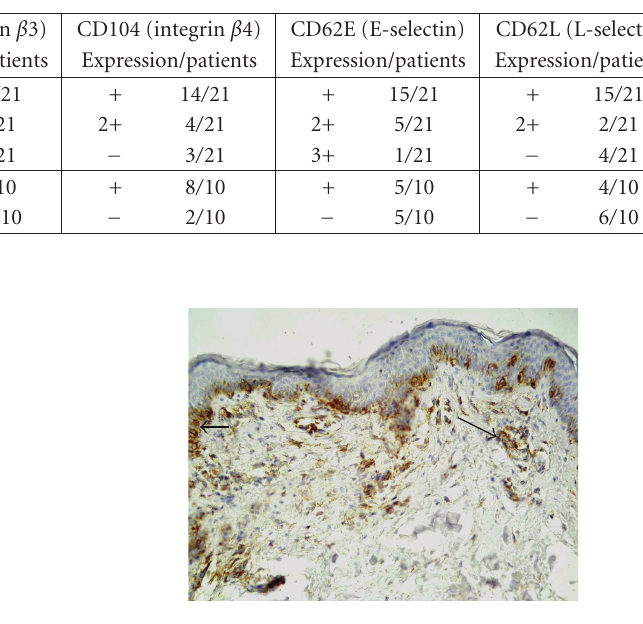
Figure 1: Skin lesions in BP, immunohistochemistry. Moderate ex- pression of β 1 integrin in basal keratinocytes and weak in the whole epidermis and blister fluid (original magnification x100).